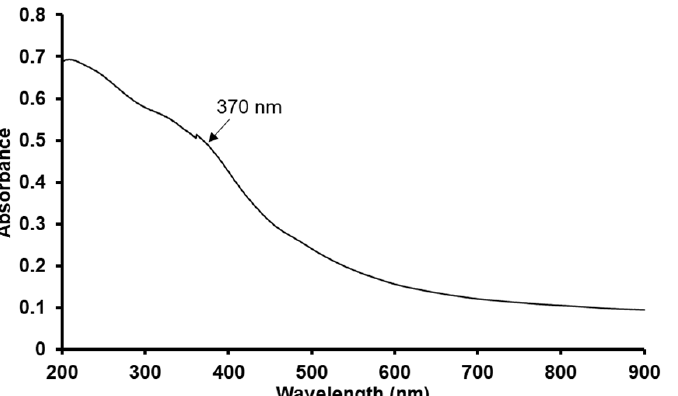
Figure 2. Ultraviolet-visible (UV-vis) spectrum of the synthesized Fe 3 O 4 nanoparticles.